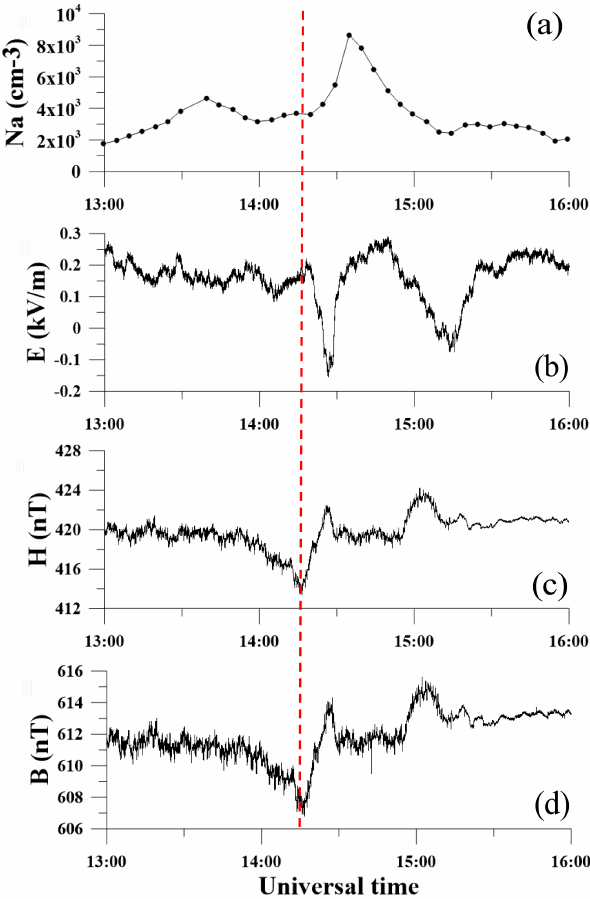
Figure 3. Observations of some atmospheric parameters and some deduced results. (a) Time series of sodium density variations at peak height 97.65km, observed by the west beam of the T/W lidar. The sodium density begins to increase at about 14:20UT. (b) Atmo- spheric electric field variations, exhibiting a synchronous overturn- ing from 14:20UT with the enhancement of sodium density (also indicated by the red dashed vertical line). Note that there is another overturning peaking at 15:15UT, without another Na S being pro- duced, which could be explained by a depletion of ions in the E S . The electric field recovers at about 15:30UT. (c) Horizontal mag- netic field observed by the fluxgate magnetometer. (d) The deduced magnetic induction intensity from observations of H , D , and Z (cid:112) H 2 + D 2 + Z 2 ). components by the fluxgate magnetometer ( B =